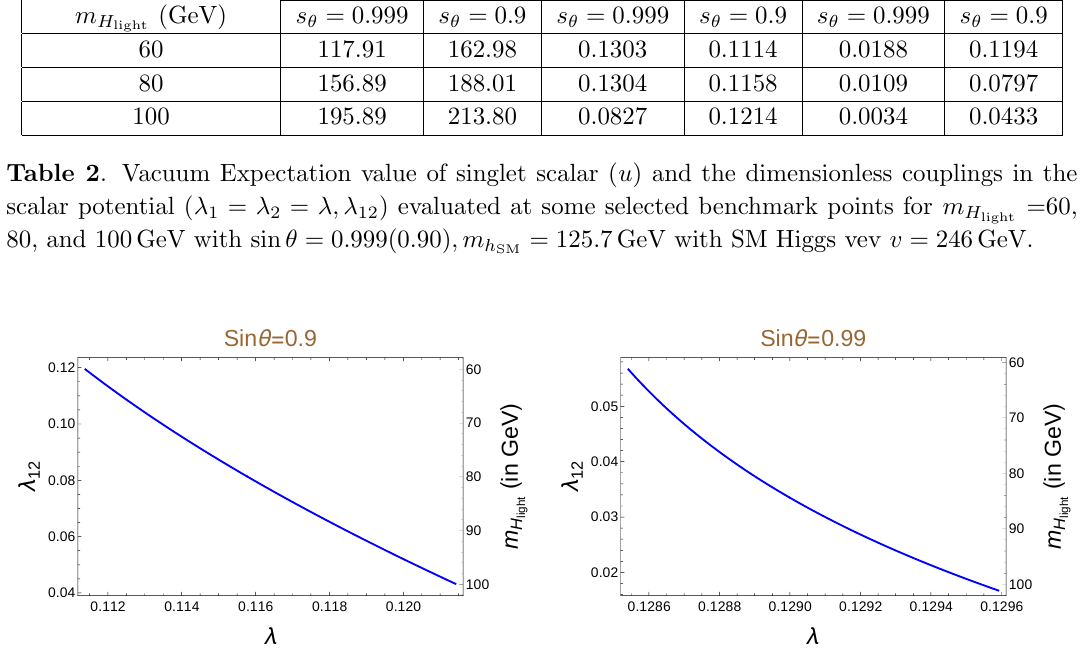
Figure 2 . Correspondence between (cid:21) = (cid:21) 1 = (cid:21) 2 and (cid:21) 12 for low mass region with the light scalar mass varying between 60 GeV (cid:20) m H (cid:20) 100 GeV, with mixing angle (cid:12)xed at sin (cid:18) = 0 : 9 (for left light panel) and sin (cid:18) = 0 : 99 (for right panel)